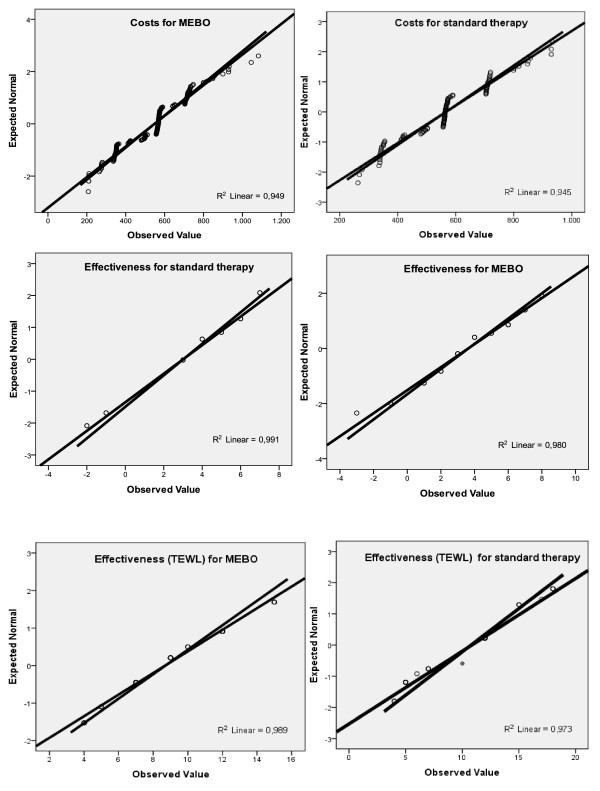
Q-Q plots of costs and effectiveness for MEBO group and standard therapy group.